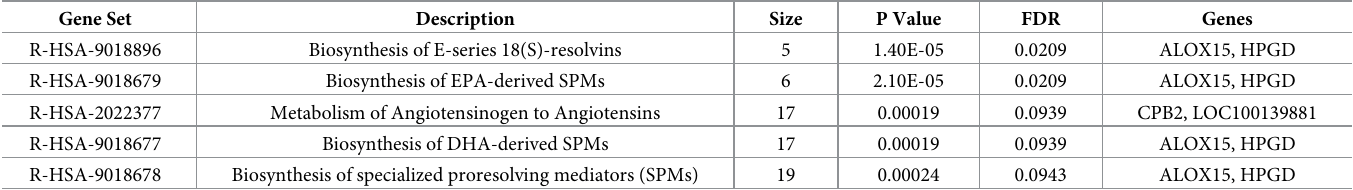
Table 2. Significantly enriched biological pathways with associated DEGs in cattle at arrival.